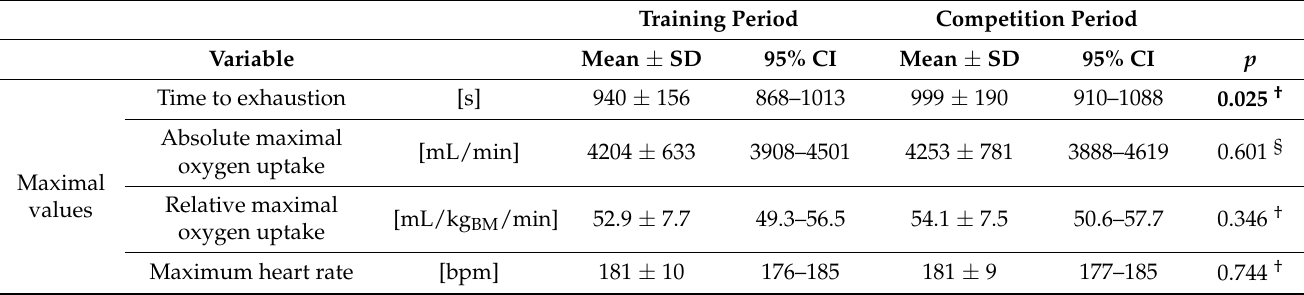
Table 5. Aerobic capacity during the training and competition